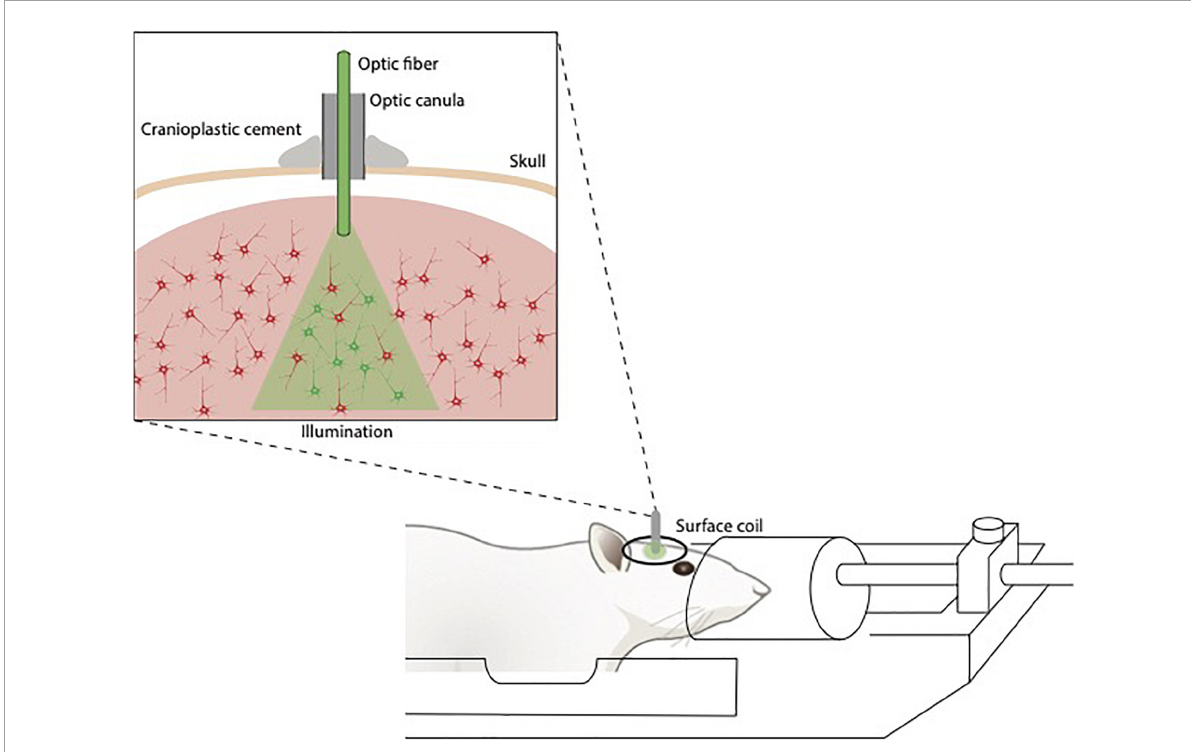
FIGURE3 Illustration of fiberoptics/fMRI setup. The optic fibers are implanted above the opsin/calcium indicator-stained area, fixed to the skull, guided through the coil and connected to the stimulation/detection unit.